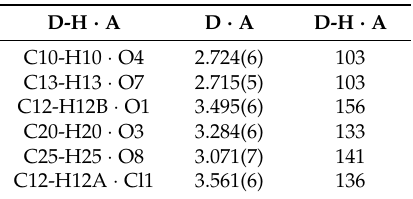
Figure 6. View of the three-dimensional supra-molecular structure of complex 1 showing the C-H ··· O, C-H ··· Cl hydrogen bondings. Table 5. Hydrogen bondings (Å, °) for complex 1 .